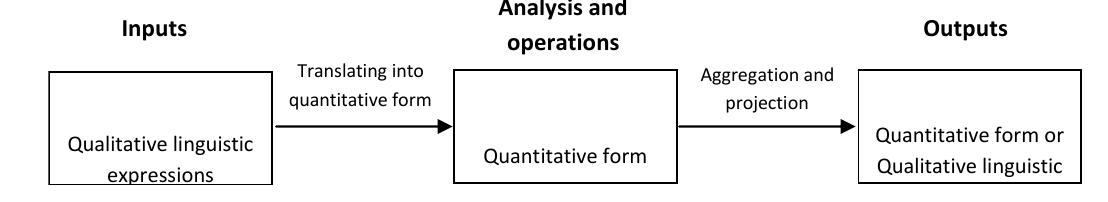
Figure 1: Methodology